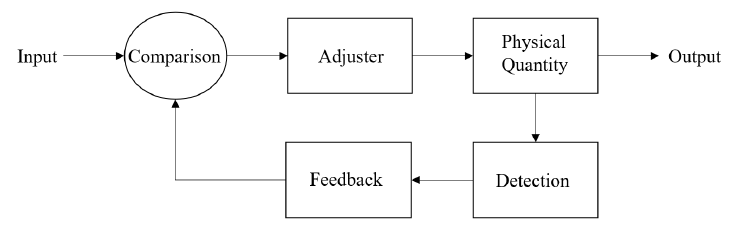
Figure 13. Closed-loop servo program block diagram.